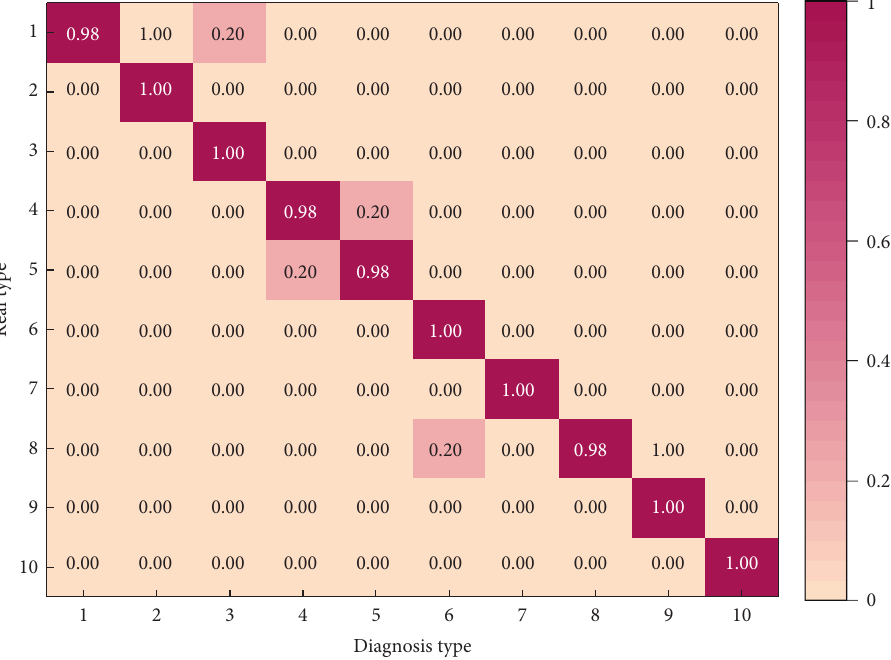
Figure 10: Confusion matrix of using 22 features selected by CatBoost.